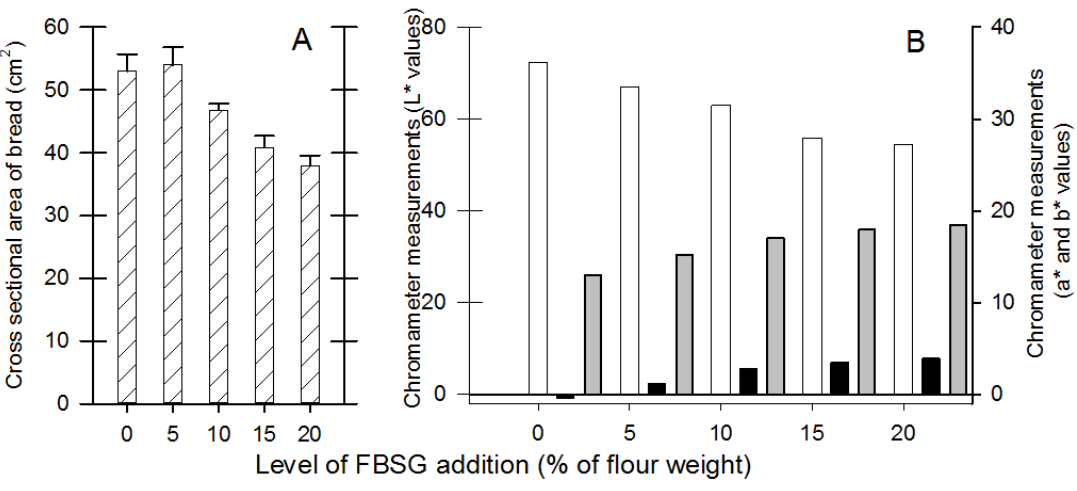
Figure 2. The influence of dried fermented brewers spent grain (FBSG) on the physical appearance of the baked breads. ( A ) Cross-sectional areas of sourdough breads ( n = 3 determinations). ( B ) L-a-b colour of sourdough bread crumb, white bars (L * values), black bars (a * values), grey bars (b * values) ( n = 10 determinations).